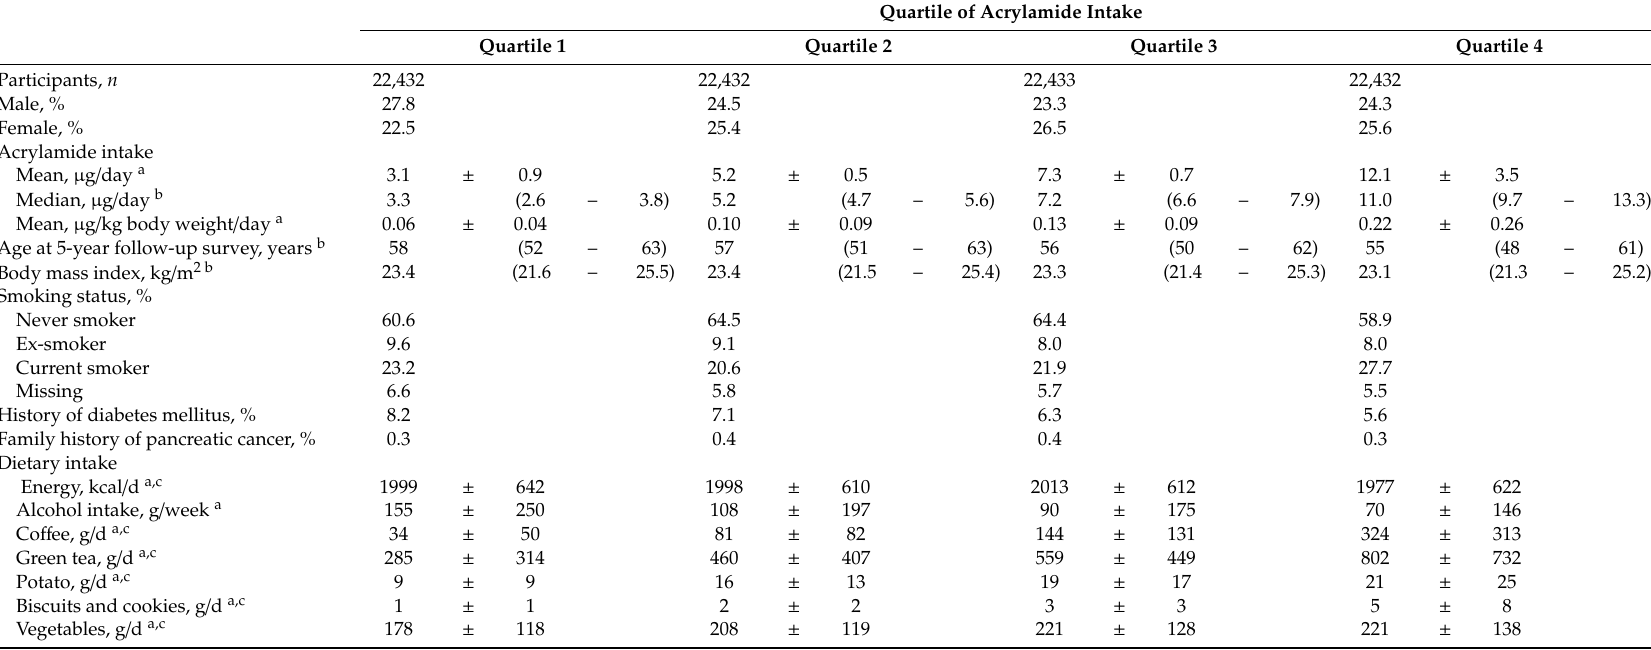
Table 1. Baseline characteristics of the study participants ( n = 89,729) according to quartile of dietary acrylamide